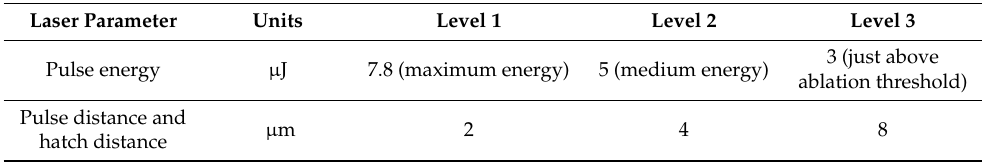
Table 1. Di ff erent levels of parameter